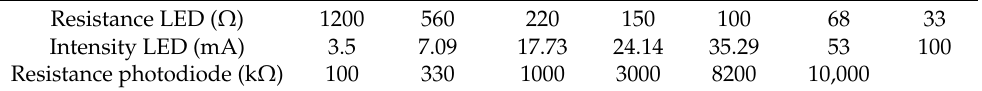
Table 1. Resistance and intensity in IR LED and the resistance in the voltage divider. Resistance LED ( Ω ) 1200 560 220 150 100 68 33 Intensity LED (mA) 3.5 7.09 17.73 24.14 35.29 53 100 Resistance photodiode (k Ω ) 100 330 1000 3000